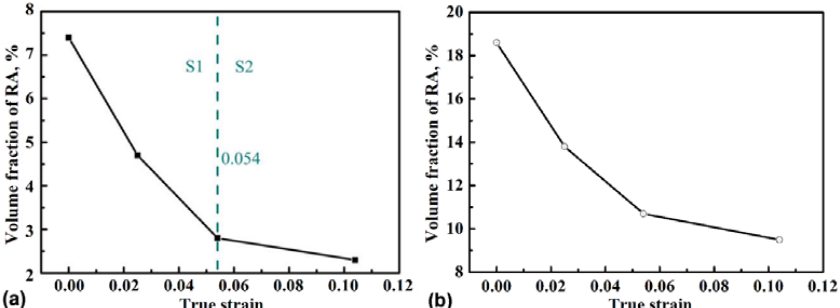
Figure 5. Variation of volume fraction of retained austenite (RA) in the tested region ( a ), and in the specimen tested via XRD ( b ), with true strain.